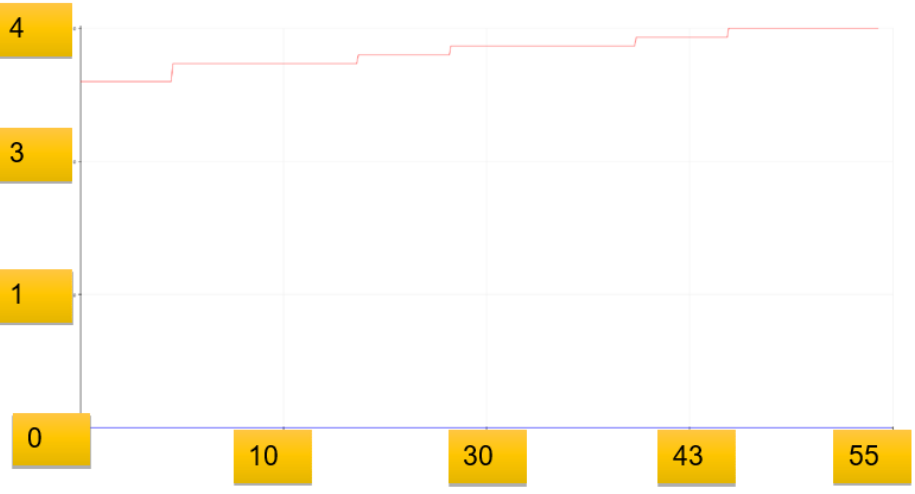
Figure 14. Temperature sensor in the presence of flame.